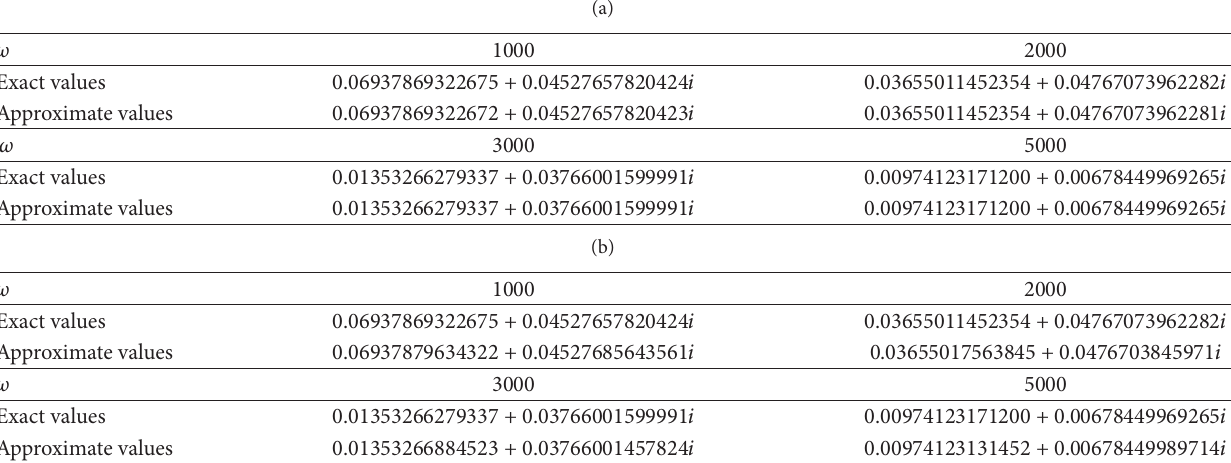
3 (𝑥 − 2) −(1/2) (3 − 𝑥) −(1/2) sin 𝑥𝑒 𝑖𝜔𝑥 𝑑𝑥 . 2